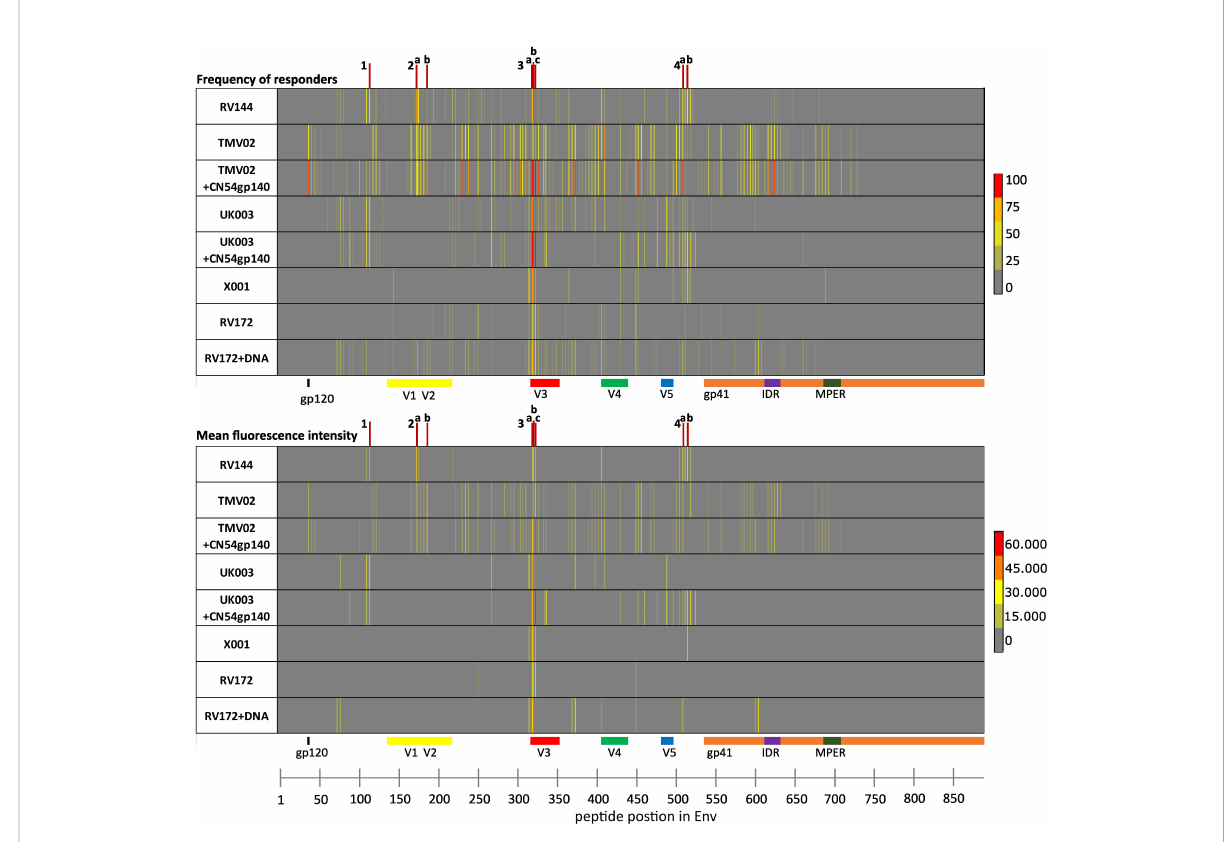
FIGURE 2 Analysis of IgG epitope recognition along the HIV-1 Env protein in the 8 different vaccine groups. The frequency of responders (FOR; upper panel) and the mean fl uorescence intensities (mean FI; lower panel) plotted against individual antigenic regions along the entire HIV-1 Env as included in the 10 full-length Env immunogen sequences comprising the array backbone. Each row of the respective heat maps displays the Env-speci fi c IgG responses of one of 8 vaccination groups, tested four weeks after the last vaccination. IgG responses against individual antigenic regions were considered positive if the corresponding FI was above 3,500 after subtraction of the pre-vaccination value. The mean FI was calculated using the maximum FI values per position for each participant, only if peptide-speci fi c IgG responses occurred in at least 25% of the vaccinees. IDRs 1 – 4 are indicated by red lines and are listed in Table